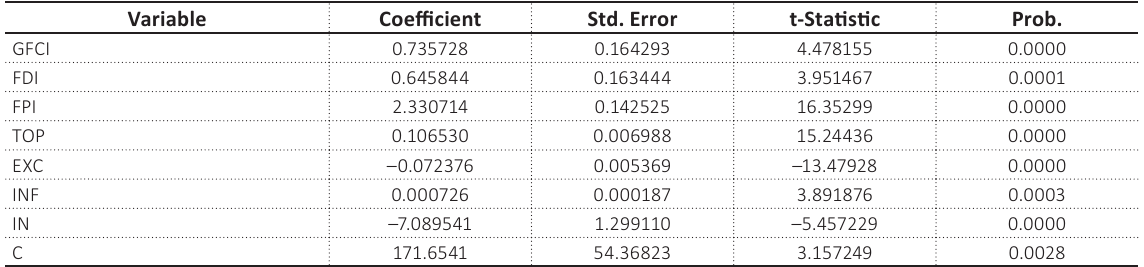
Table 4. Fixed effects test result